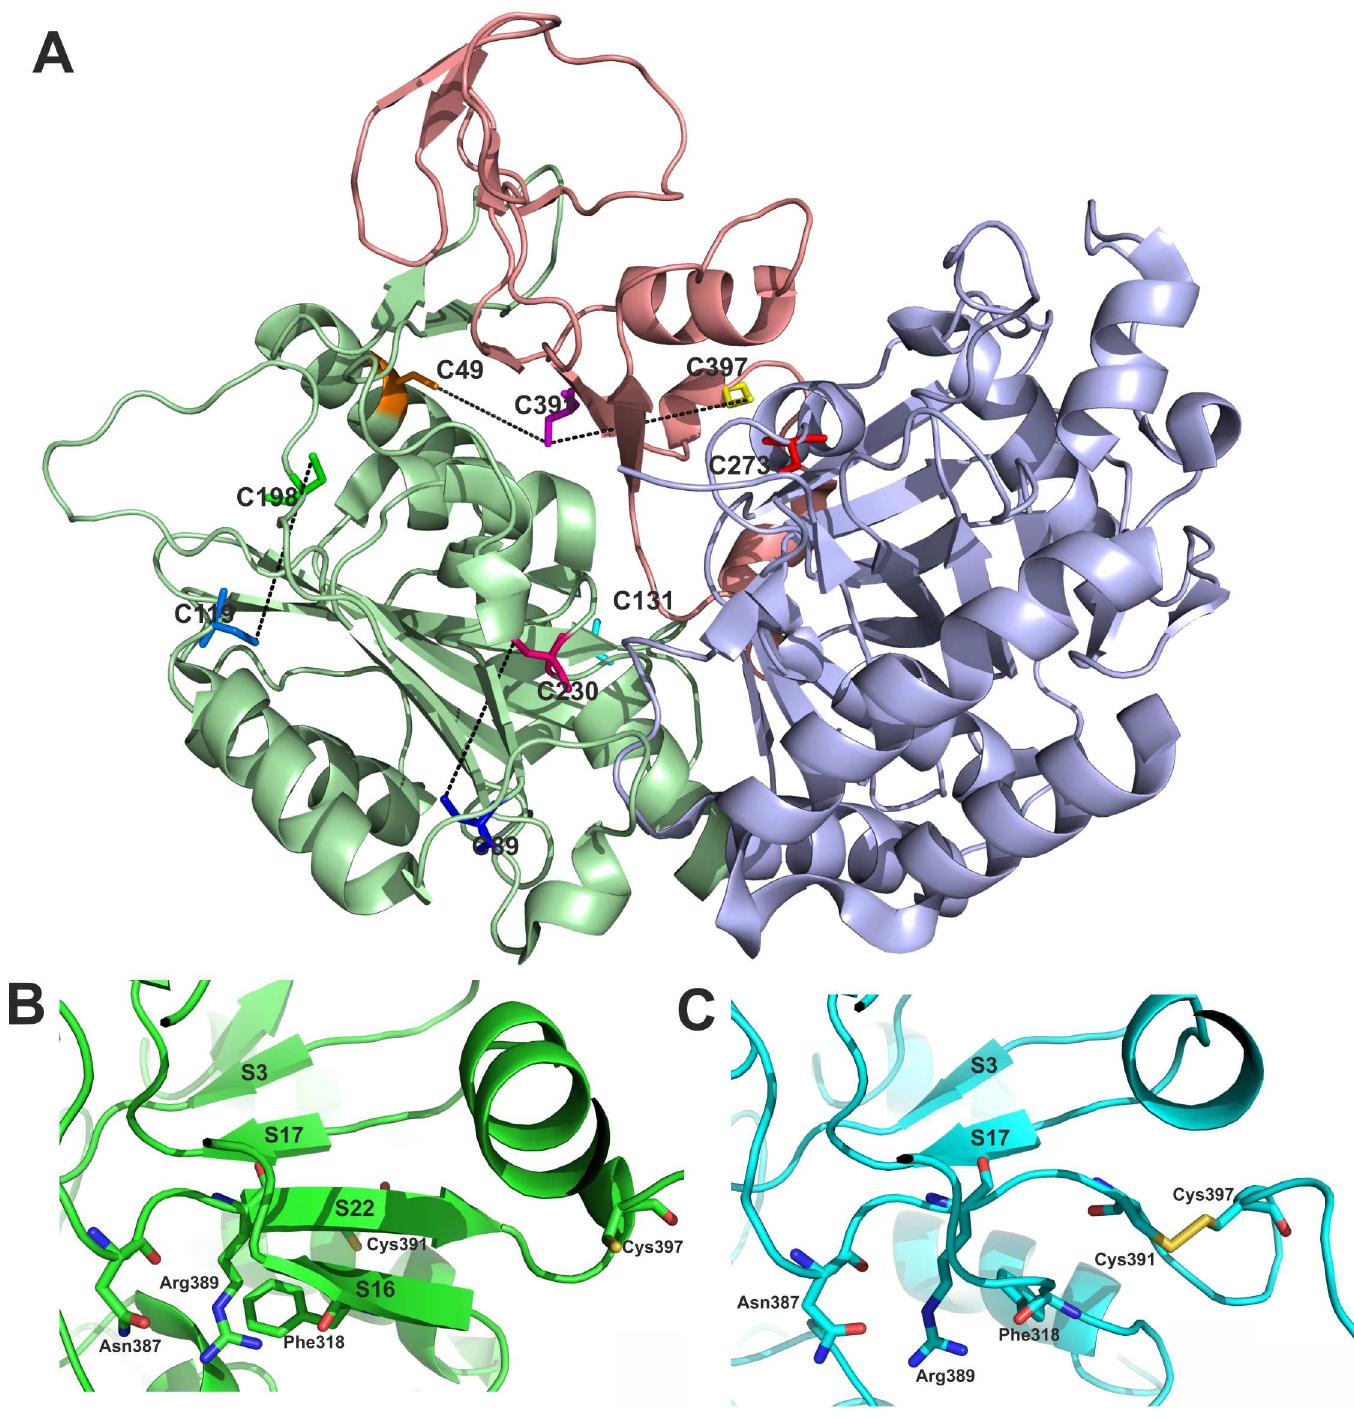
Fig 1. Cysteine residues in MTb Pck. (A) Cys residuedistributionin Pck. Cys residuesare shown as sticks, and the potentialS–S bridgesare marked by dotted lines. The criterion for selectionwas a Cys–Cys distanceless than 15.0 Å in the X-ray structure of reducedform of MTb Pck (PDB code: 4R43) [10]. (B) Position and orientationof C391, C397 in the X-ray structure of reducedwt Pck[10]. C391 is localizedin S22 β -strand. (C) The local structural changesin S22 and S16 β -strandsin the C391-C397disulfidecontainingPck model preparedby moleculardynamics simulation. Color codingof sticks: blue–nitrogen, red– oxygen,